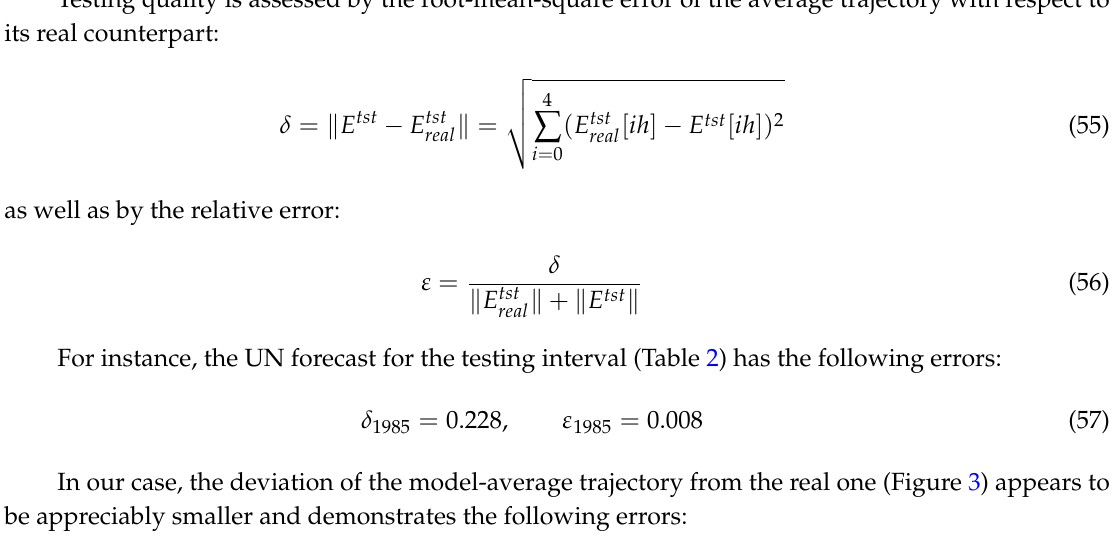
Figure 3 has the following notation: 1, the ensemble-average trajectories of population dynamics; 2, real population dynamics on the testing interval; 3, population dynamics on the testing interval according to the UN forecast of the year 1998; 4, the boundaries of the first and the third quartiles. The same model-generated ensemble for testing interval can be presented as a box plot with median mark and interquartile ranges; see Figure 4.